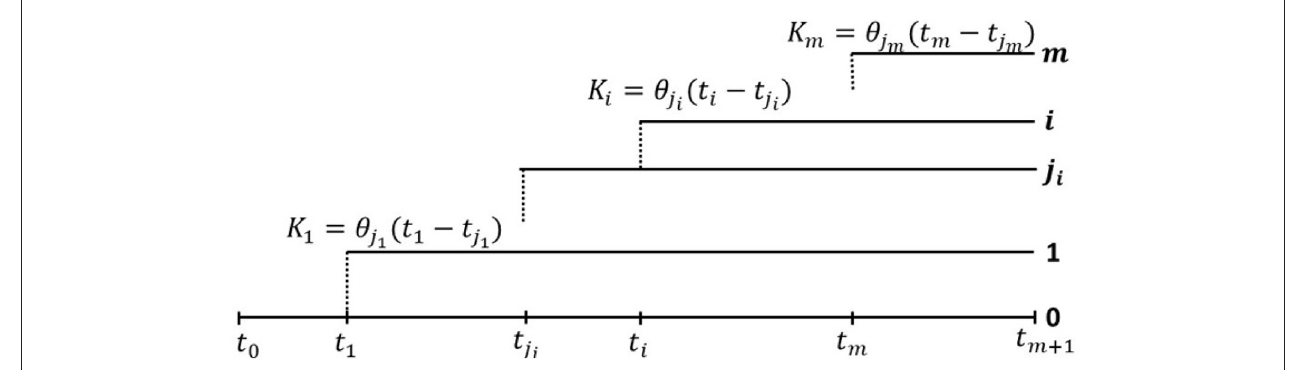
FIGURE 3 | General clonal hierarchy of tumor cells in the model of Dinh et al. (2020b). At time t i , Clone i , 1 ≤ i ≤ m , branches off from Clone j i , where 0 ≤ j i ≤ m − 1, and j i < i , as depicted in figure. Let us note that j 1 = 0, and for completeness we assume j 0 = 0. Moreover we assume that cells in each Clone i mutate (neutrally) according to the infinite sites model (ISM), i.e., each mutation occurs at a different genome site, with mutation rates θ i per time unit per cell, and Clone i grows exponentially at rate r i (Equation 12). At time t m + 1 , the tumor is diagnosed and the cell count at this time is denoted N . Finally, we assume that each clone is initiated by a single cell of clone j i , the ancestry of which is marked by K i mutations in Clone j i (Equation